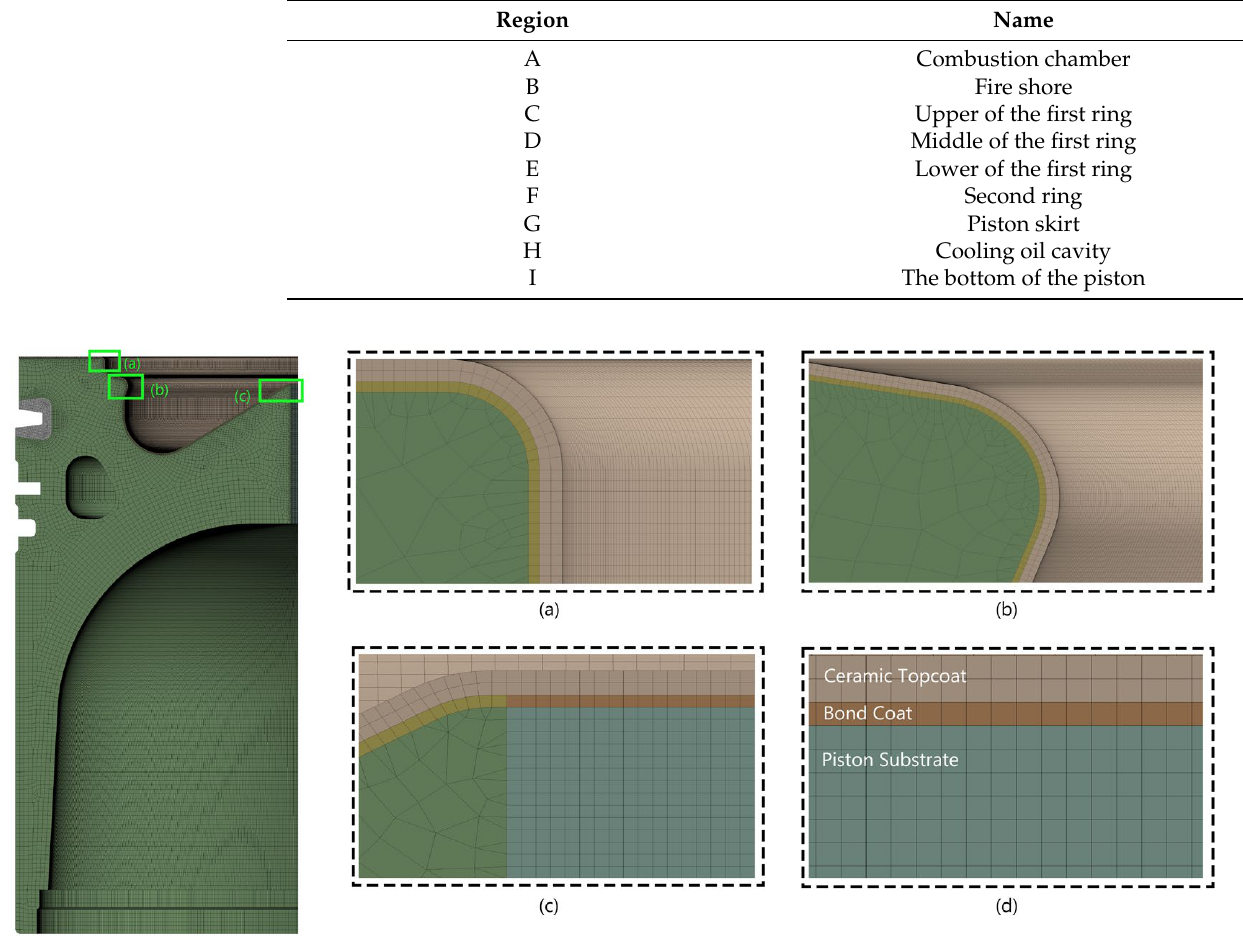
Figure 3. The simplified mode marked with path and boundary condition areas. Table 1. The name of each region.